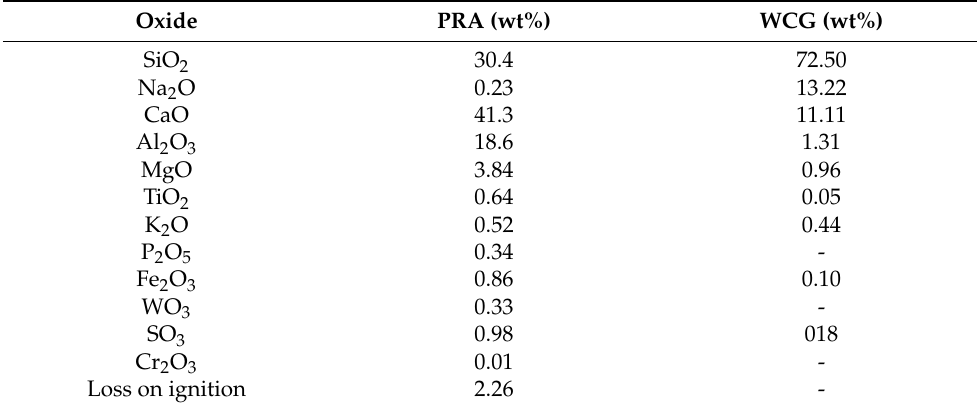
Table 1. Compositions of paper recycling ash (PRA) and waste container glass